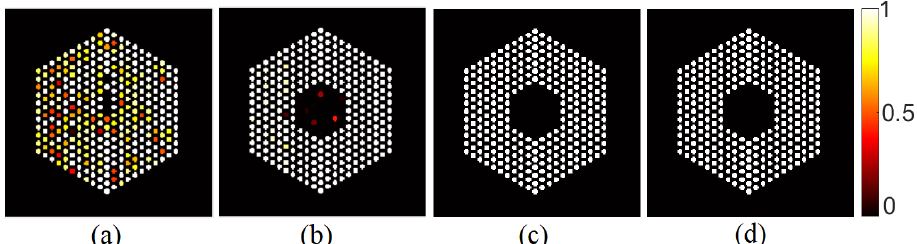
Figure 6. Probability of pin presence for ( a ) the Poisson noise case when peak value is set to 10, ( b ) the Gaussian noise case for peak value of 220 and noise variance σ 2 = 1 × 10 − 2 , and ( c ) the Poisson noise case when peak value is set to 220, and ( d ) the Gaussian noise case when the peak value is set to 220 and the noise variance is set to σ 2 = 2 × 10 − 3